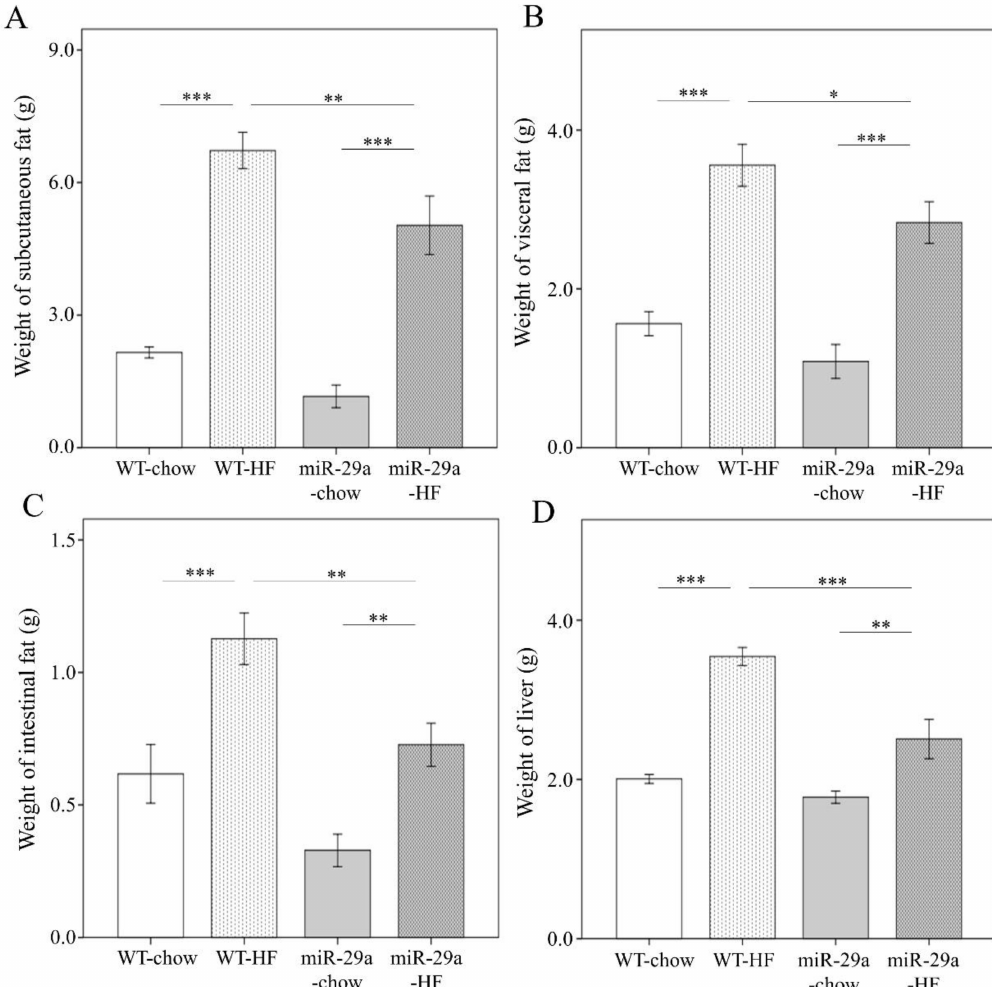
Figure 2. Overexpression of miR-29a significantly reduces fat accumulation in adipose tissue and liver weight in the context of chronic HFD. Various tissue parts were dissected and weighed immediately after sacrifice, with weight of ( A ) subcutaneous, ( B ) visceral, ( C ) intestinal fat tissue, and ( D ) liver. Data calculated from seven to ten mice per group are expressed as mean ± SE. ** p < 0.01 and *** p < 0.001 between the indicated groups. WT, wild type mice. HFD, high-fat diet. miR-29a, mice harboring overexpression of